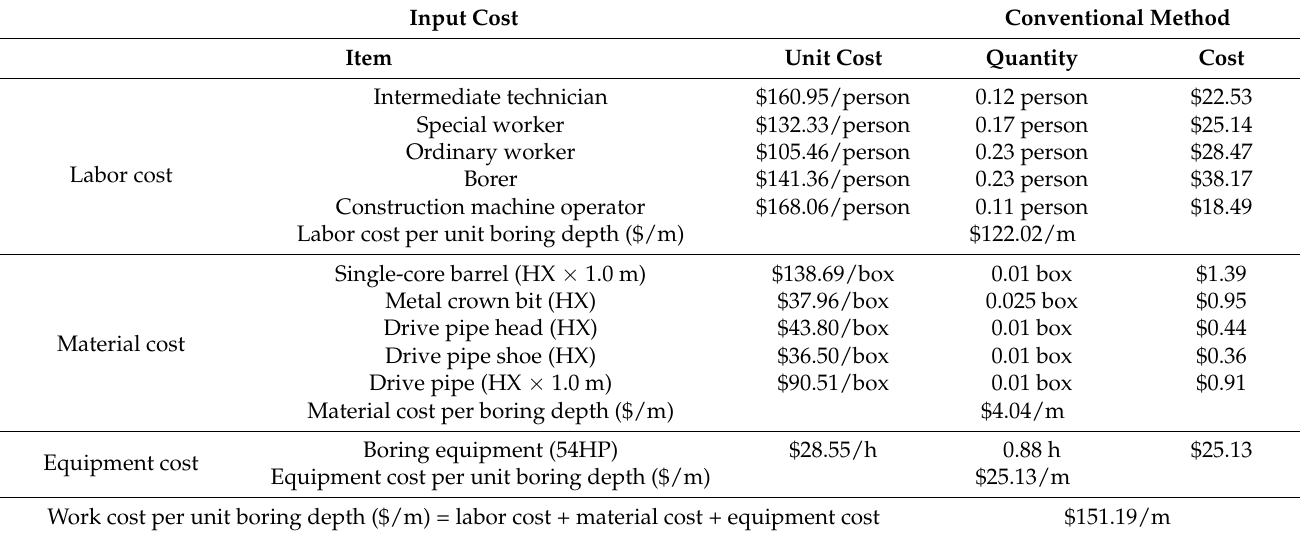
Table 5. Boring cost for the conventional